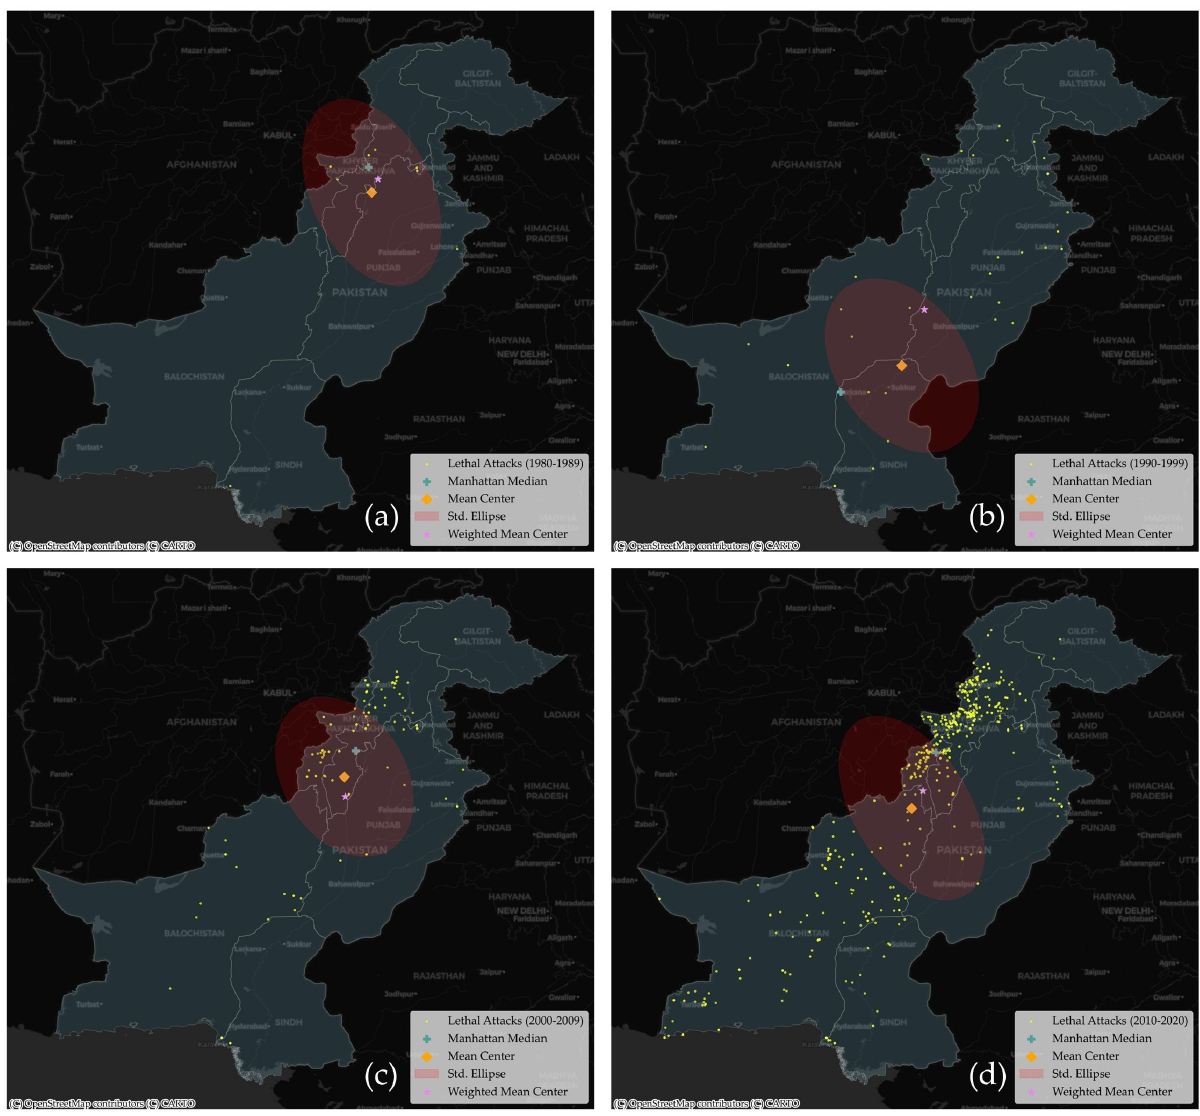
Figure 10. Spatiotemporal evolution of lethal attacks in Pakistan. ( a ) Lethal attacks in the decade 1980–1989. ( b ) Lethal attacks in the decade 1990–1999. ( c ) Lethal attacks in the decade 2000–2009. ( d ) Lethal attacks in the decade 2010–2020. Figure 13 depicts the ECDF plot for the time between consecutive lethal attacks (left) and the associated QQ plot (right). A total of 95% of the lethal attacks happened within 50 days of the previous attack. In India, the longest period without a fatal attack is 1700 days. The observed data’s QQ plot suggests an exponential distribution. The best-fit distribution for the observed data is an exponential distribution with a rate parameter of 17.74